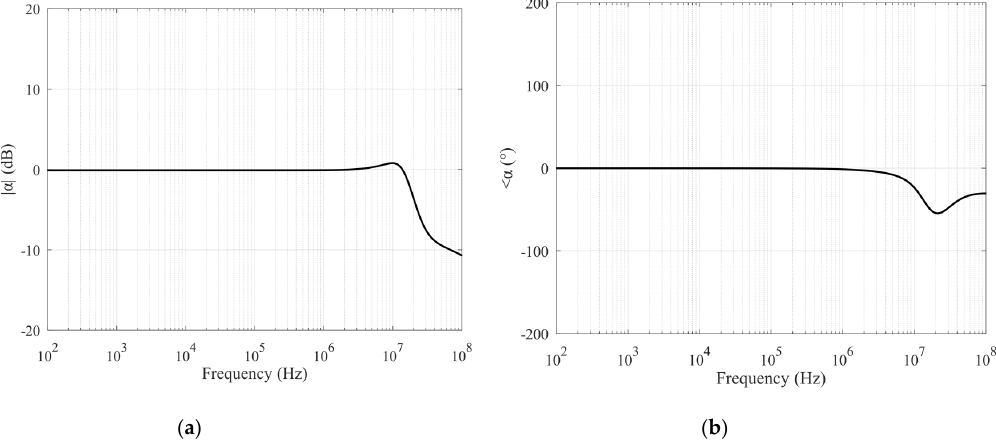
Figure 5. Voltage buffer characteristics: magnitude ( a ) and phase ( b ) of α .